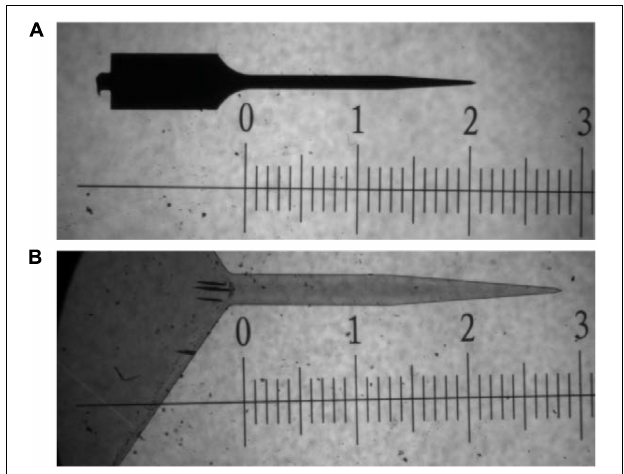
FIGURE 6 | Bright field microscope image comparing dimensions of probes used in study. (A) uncoated silicon probe and (B) thiol-ene probe. Both images are taken at 5 × magnification. Scale is in